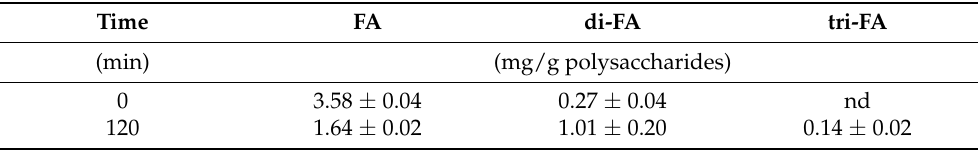
Values are presented as means ± standard deviations ( n = 3). nd = non